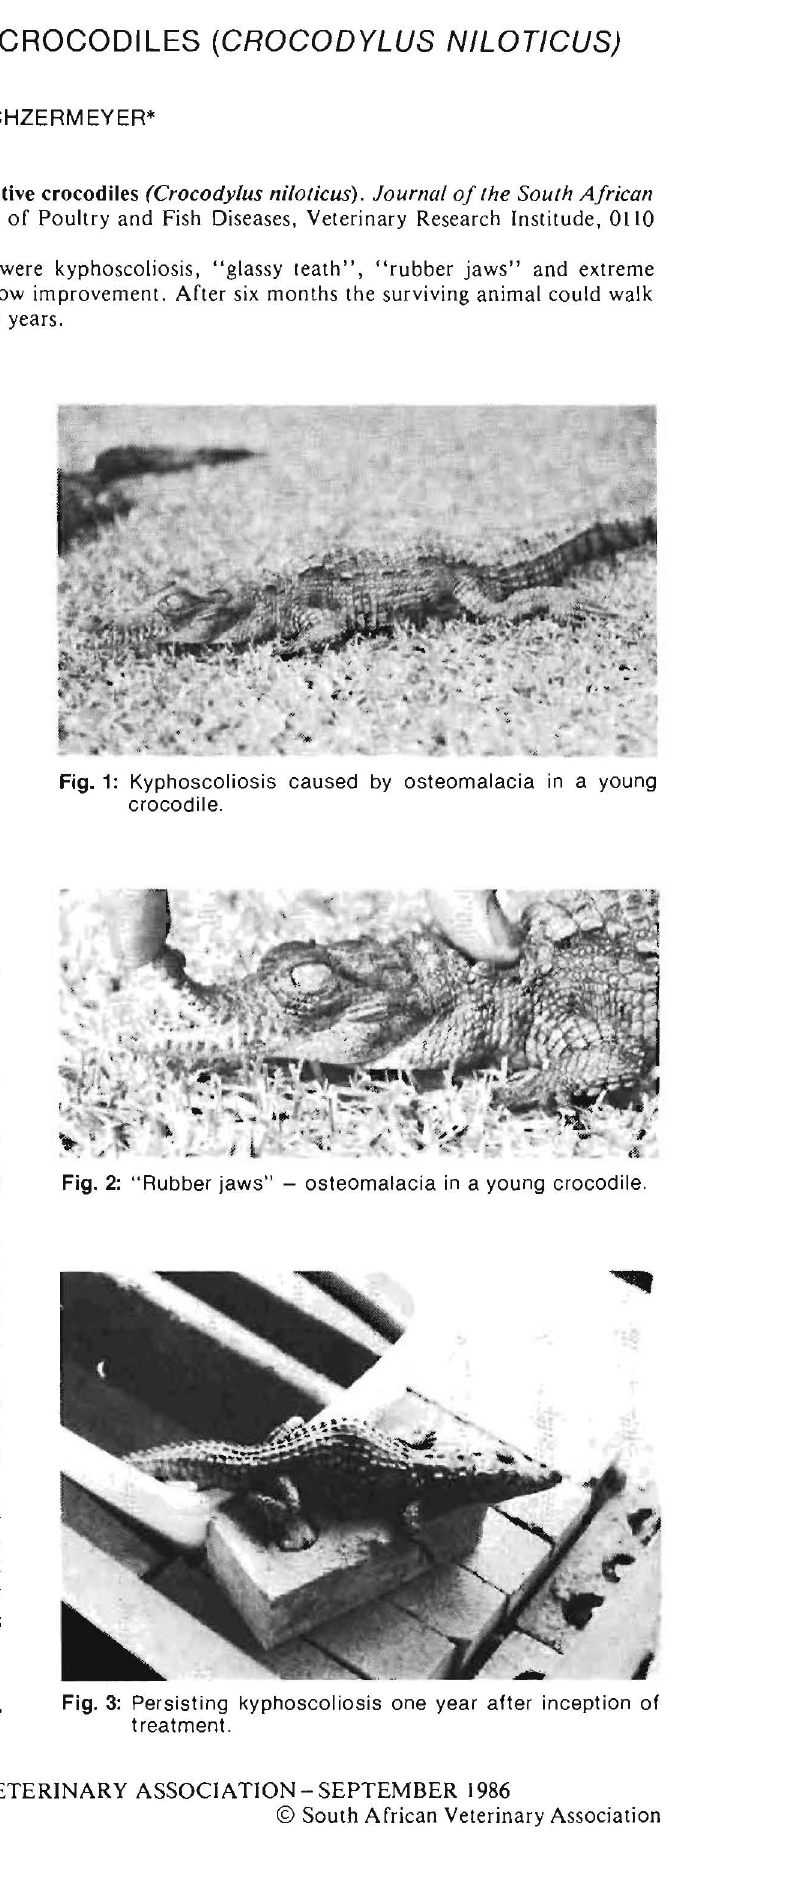
Fig. 3: Persisting kyphoscoliosis one year after inception of